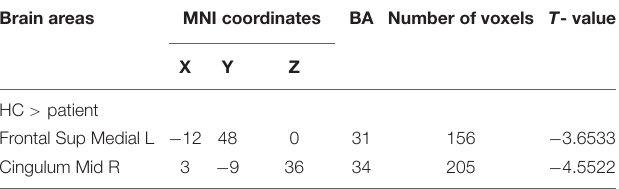
TABLE 2 | Brain regions with significant differences in brain activities between CS and HCs.